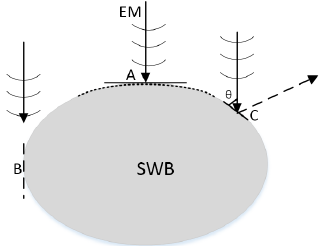
Figure 16. A sketch of the phenomenon “missing